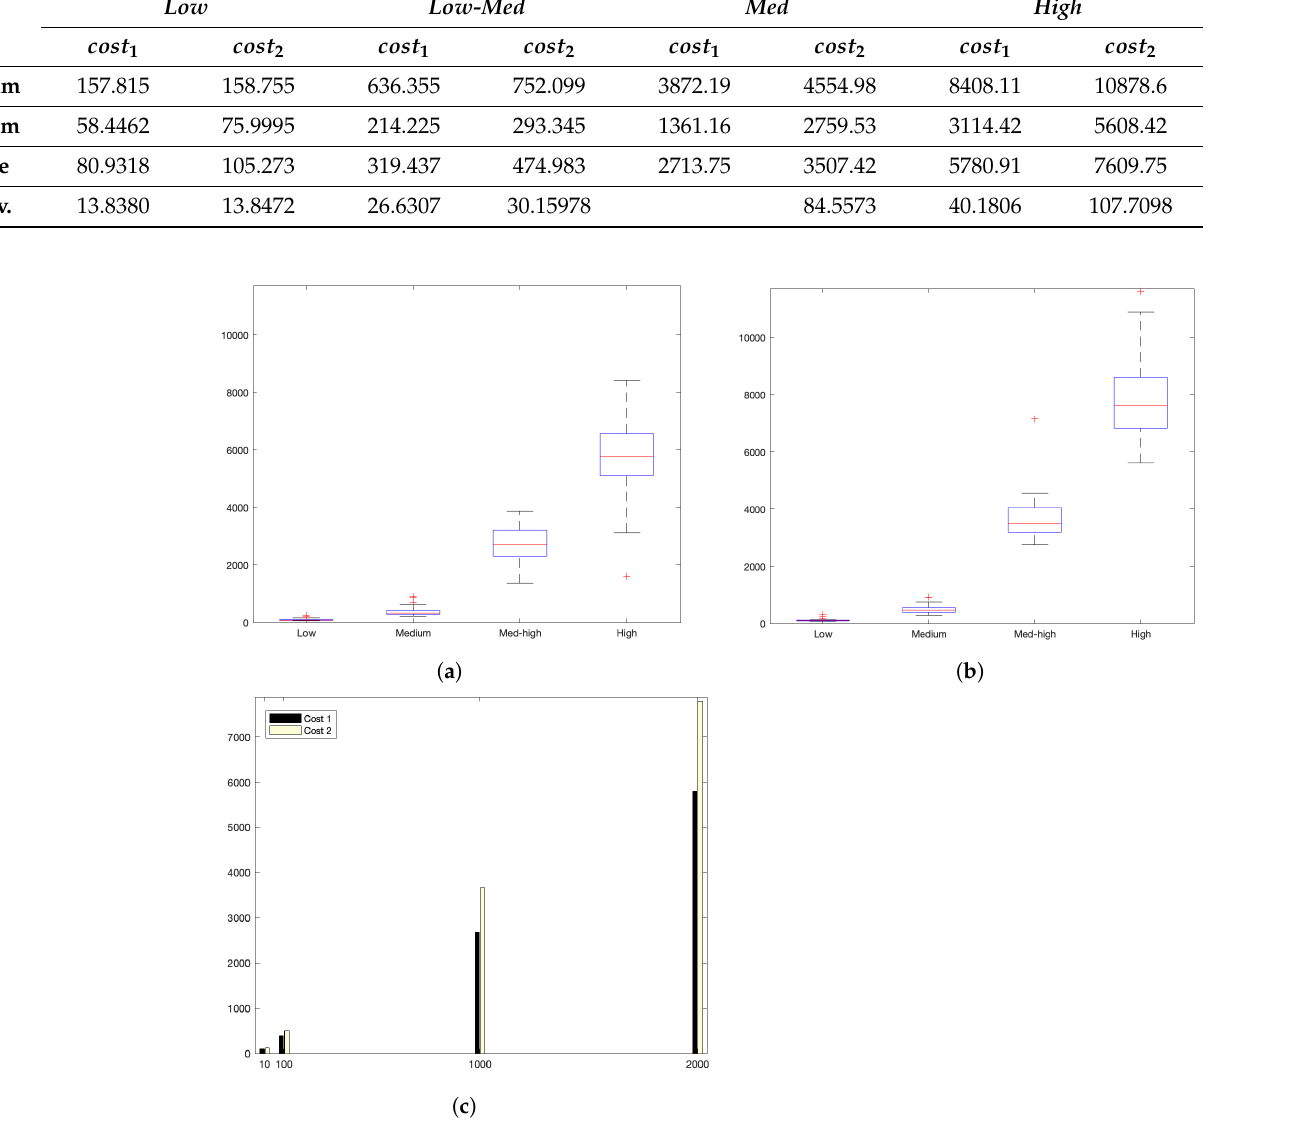
Figure 14. Summary of cost values for all scenarios. ( a ) cost 1 . ( b ) cost 2 . ( c ) Average